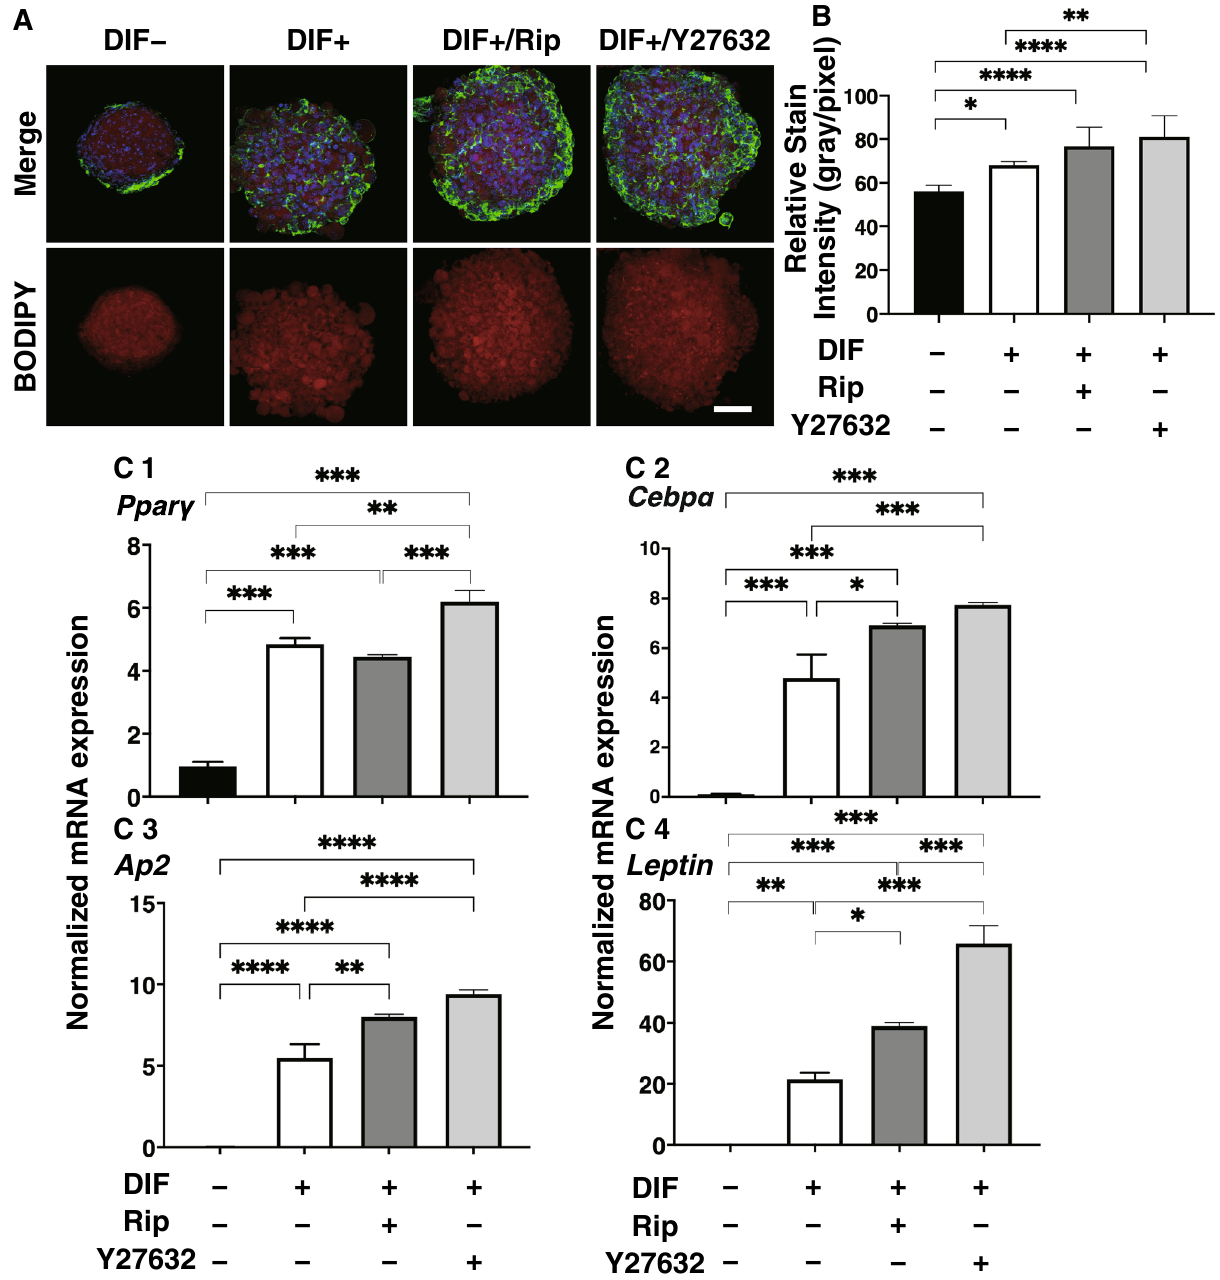
Figure 5. Effects of ROCK-i on adipogenesis of 3T3-L1 3D organoids. 3T3-L1 3D organoids from Day 7 was prepared under several conditions; preadipocytes of the 3T3-L1 cells (DIF−) and their adipogenic differentiation (DIF+) without or with 10 µM Ripasudil (Rip) or Y27632. These samples were immunostained with DAPI (blue), phalloidin (green) and BODIPY (red) ( A , scale bar: 100 μm) and their staining intensities were plotted ( B ). The mRNA expressions of adipogenesis related genes including Pparγ , Cebpa and Leptin under above conditions were plotted in ( C ) 1–3. All experiments were performed in duplicate using fresh preparations, each consisting of 16 organoids. Data are presented as arithmetic means ± standard error of the mean (SEM). * P < 0.05, ** P < 0.01, *** P < 0.005, **** P < 0.001, and other pairs were not statistically significant (ANOVA followed by a Tukey’s multiple comparison